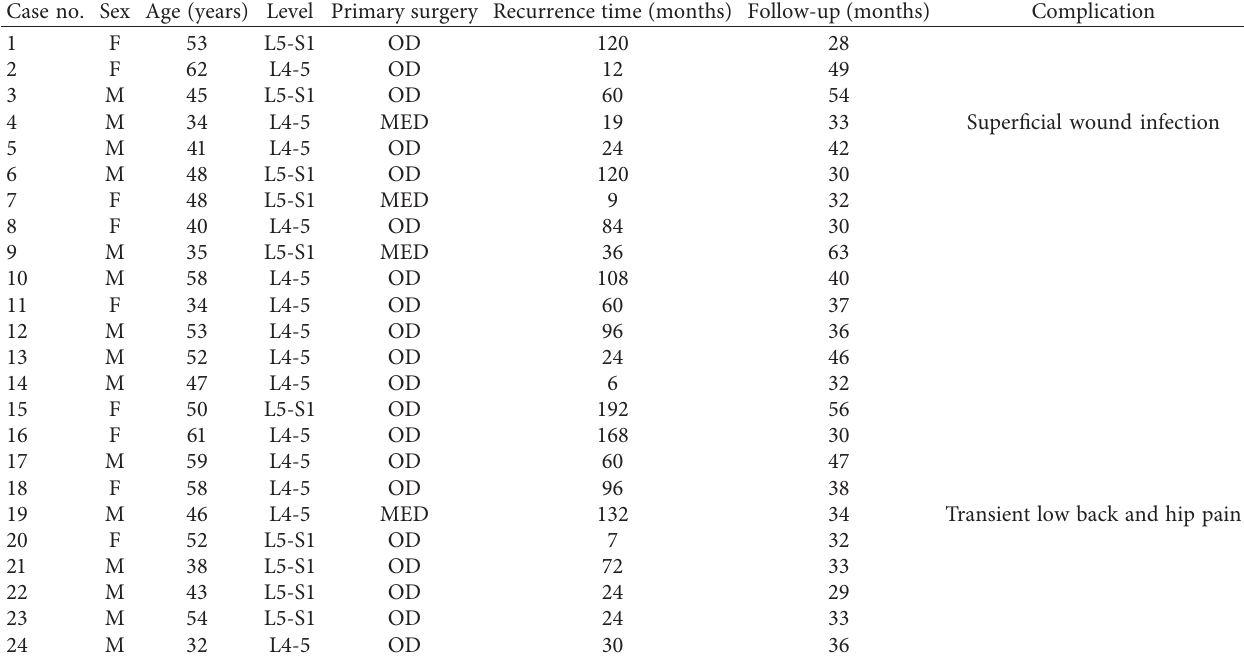
Table 1: Demographics of dynamic stabilization for recurrent lumbar disc